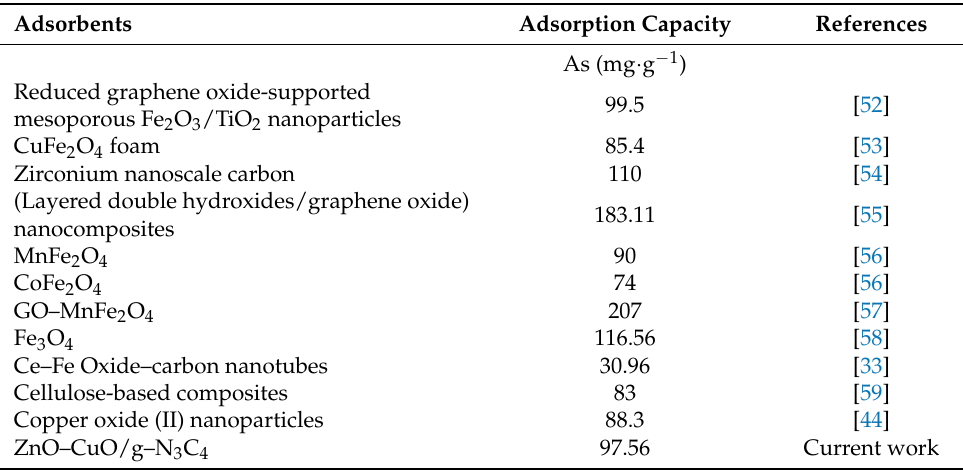
Table 1. Comparison of the maximum arsenic adsorption capacity among the prepared ZnO–CuO/g– C 3 N 4 nanocomposite and other